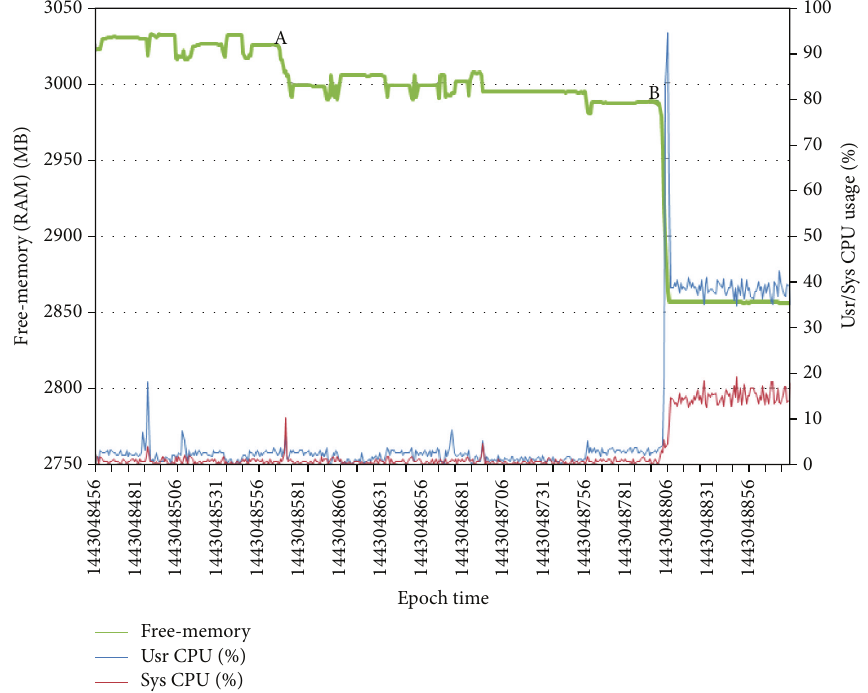
Figure 12: Memory and CPU loading characteristics for the scenario of 1-honeypot container hot spare and subsequent